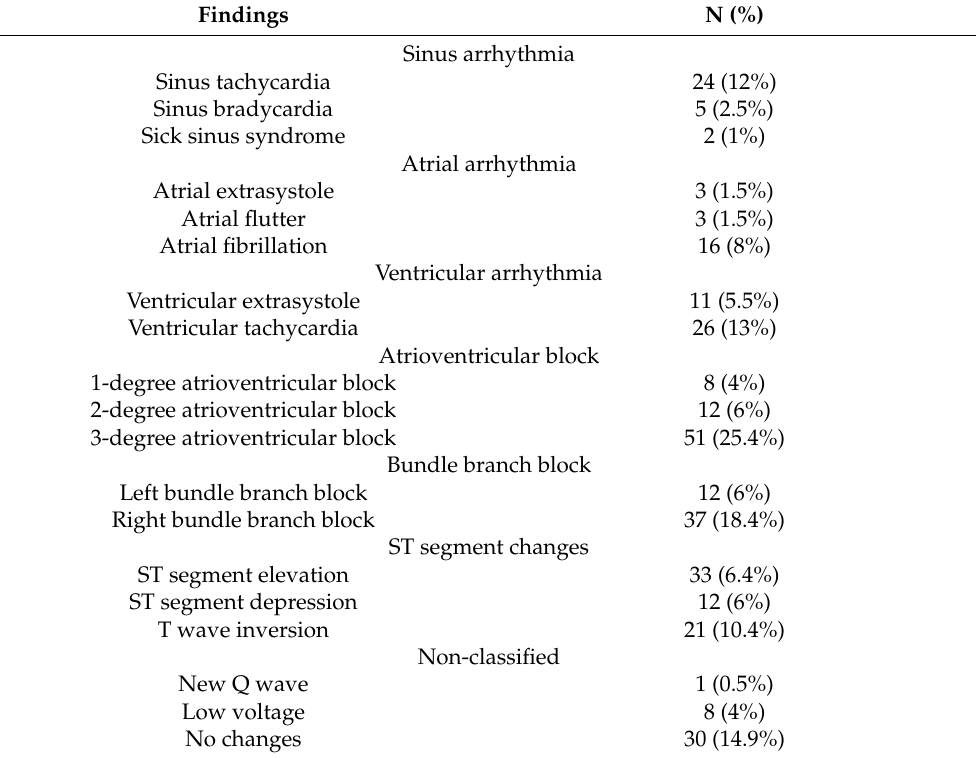
Table 5. Electrocardiographic